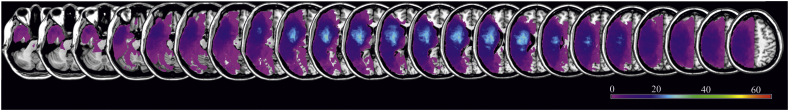
Lesion overlay. Overlay of LBD patients' lesion maps. The color bar indicates degree of overlap of lesions out of 67 patients.